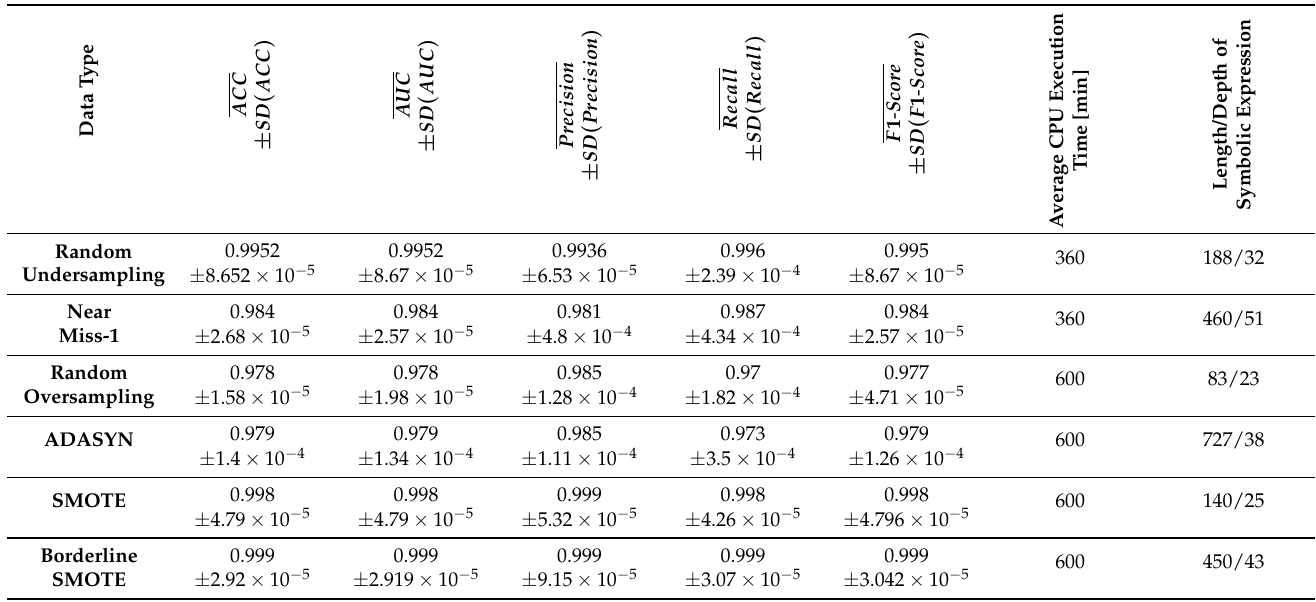
Table 7. The numerical values of mean ACC, AUC, Precision, Recall, and F1-Score with standard